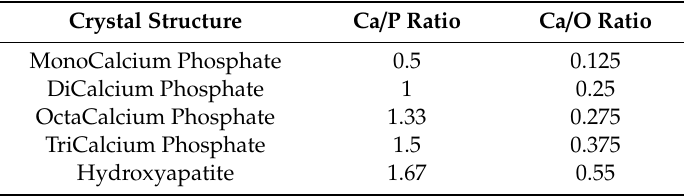
Table 1. Theoretical Ca / P and Ca / O ratio for various calcium phosphate crystals.